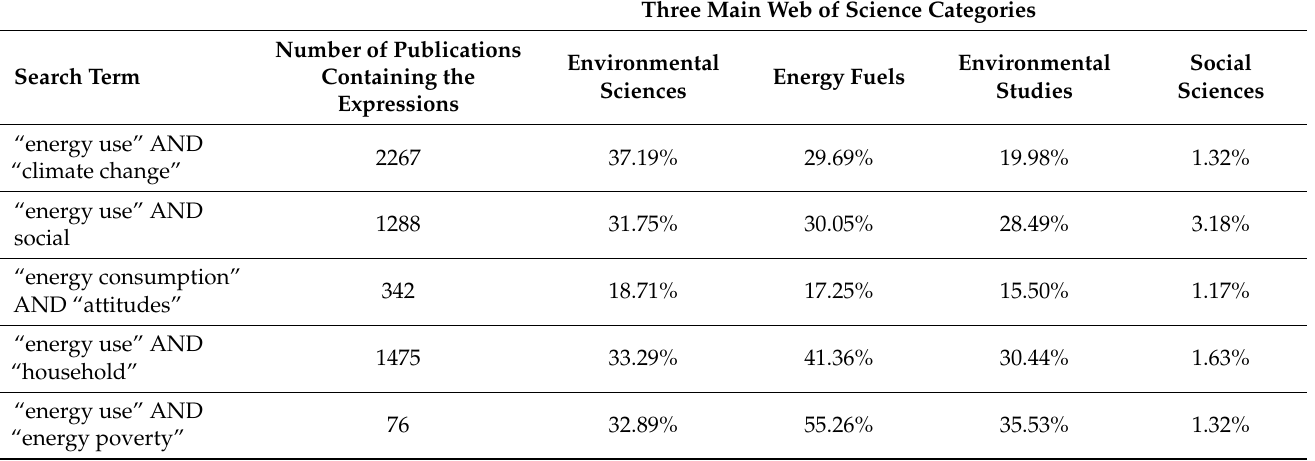
Table 1. The prevalence of the terms differs greatly